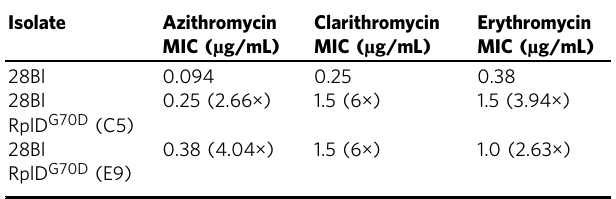
Table 1 Macrolide MICs of laboratory strain 28Bl and two isogenic derivatives con fi rms increased macrolide resistance conferred by RplD